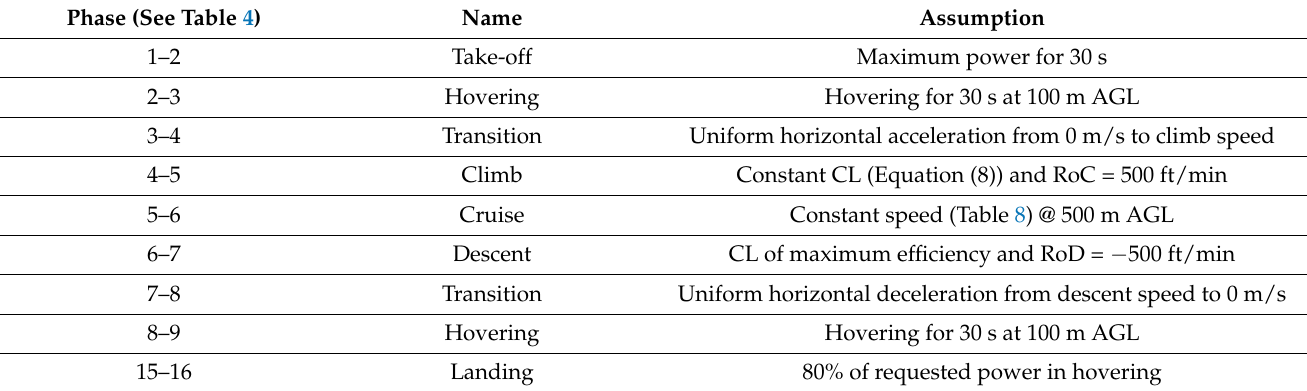
Table 11. Main assumptions of the design mission of the TiltOne